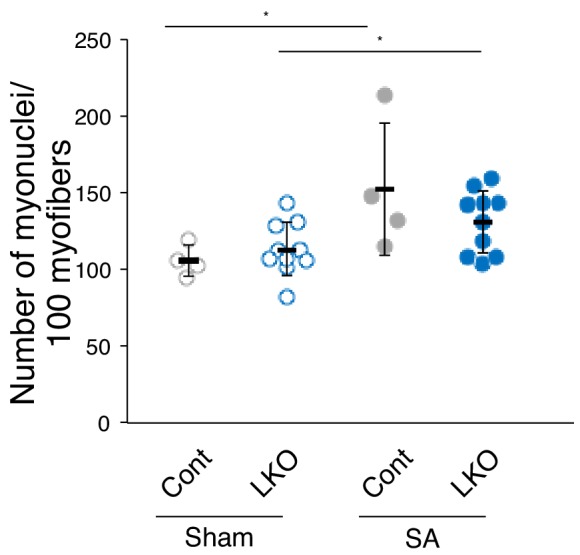
Number of total myonuclei per 100 myofibers 9 weeks after SA.The number of total myonuclei per 100 myofibers from sham (open circle) or 9 weeks after SA (closed circle) (Cont: light gray, n = 4; LKO: blue, n = 10). The number of nuclei (DAPI) located beneath dystrophin staining was counted. *p<0.05.10.7554/eLife.48284.023Figure 6—figure supplement 1—source data 1.Numerical data for making the graph in Figure 6—figure supplement 1.Experiment number corresponds to Figure 6—source data 1.